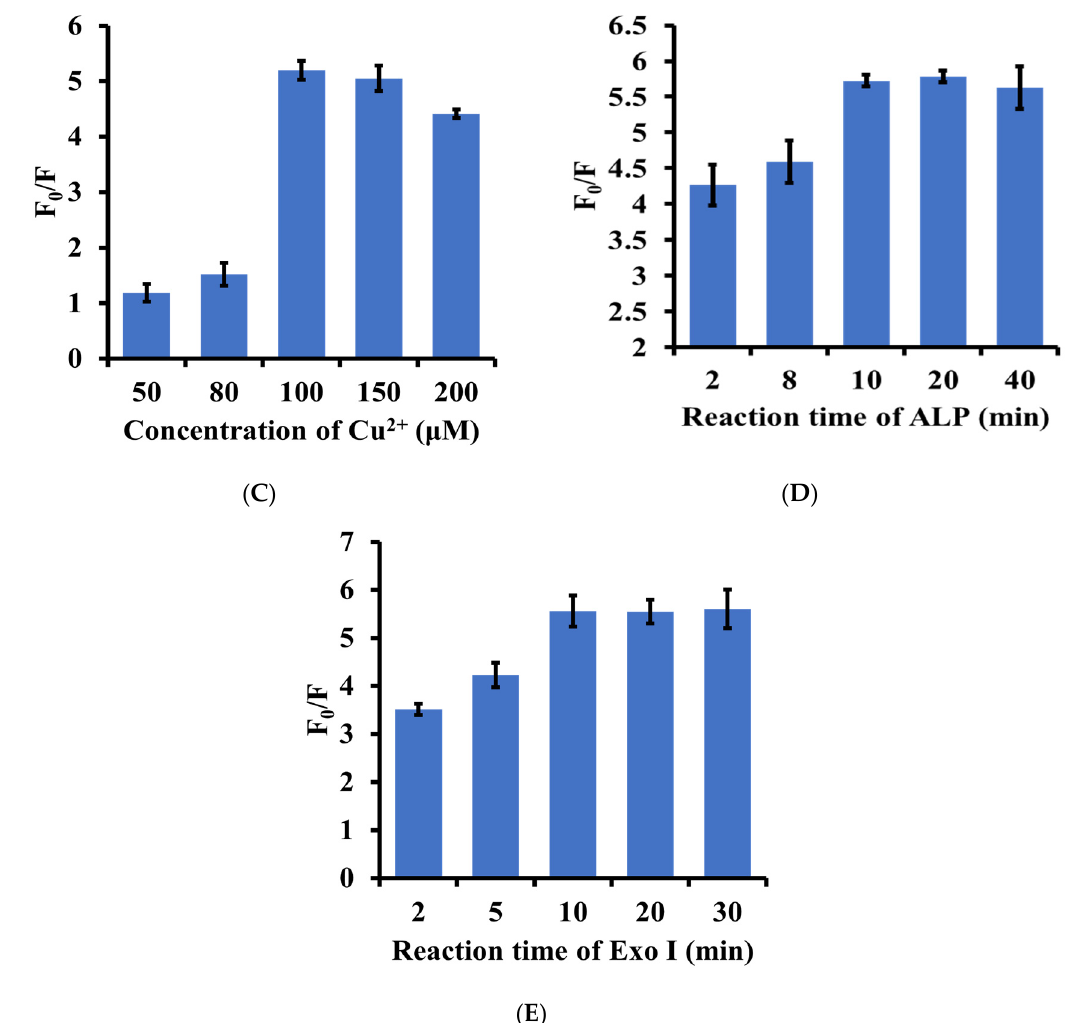
Figure 2. Optimization of reaction conditions. ( A ) The concentration of T30; ( B ) Exo I concentration; ( C ) Cu 2+ concentration; ( D ) the reaction time of ALP; ( E ) the reaction time of Exo I.